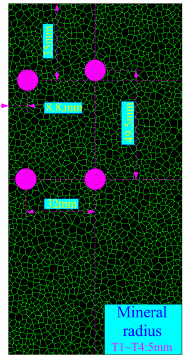
Figure 10. Two mineral circle (C 42 ) distribution diagram.